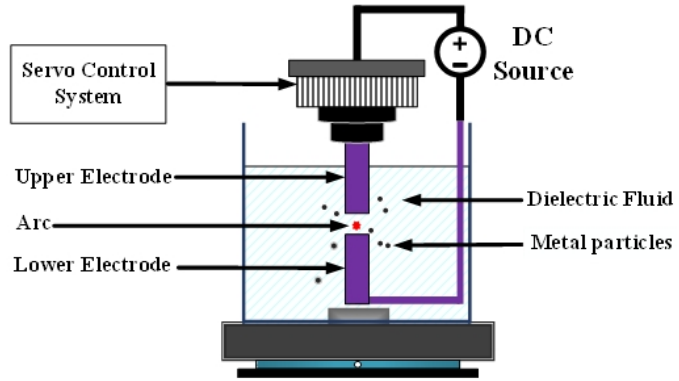
Figure 1. Electrical discharge machining.